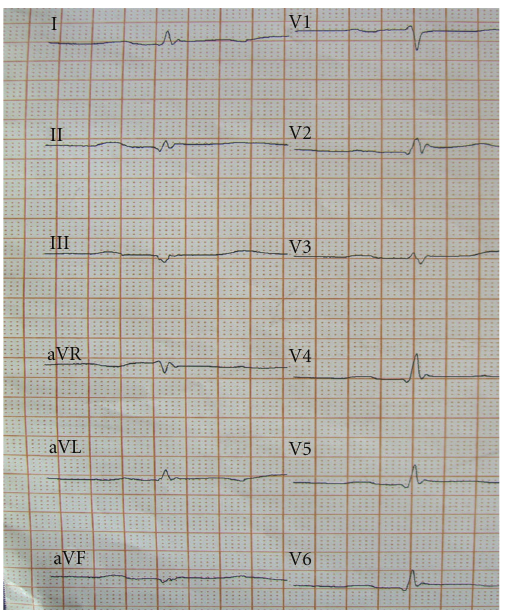
Figure 1: The initial electrocardiogram showed sinus rhythm and ST-elevations in the leads II, aVF, and V2–V6.